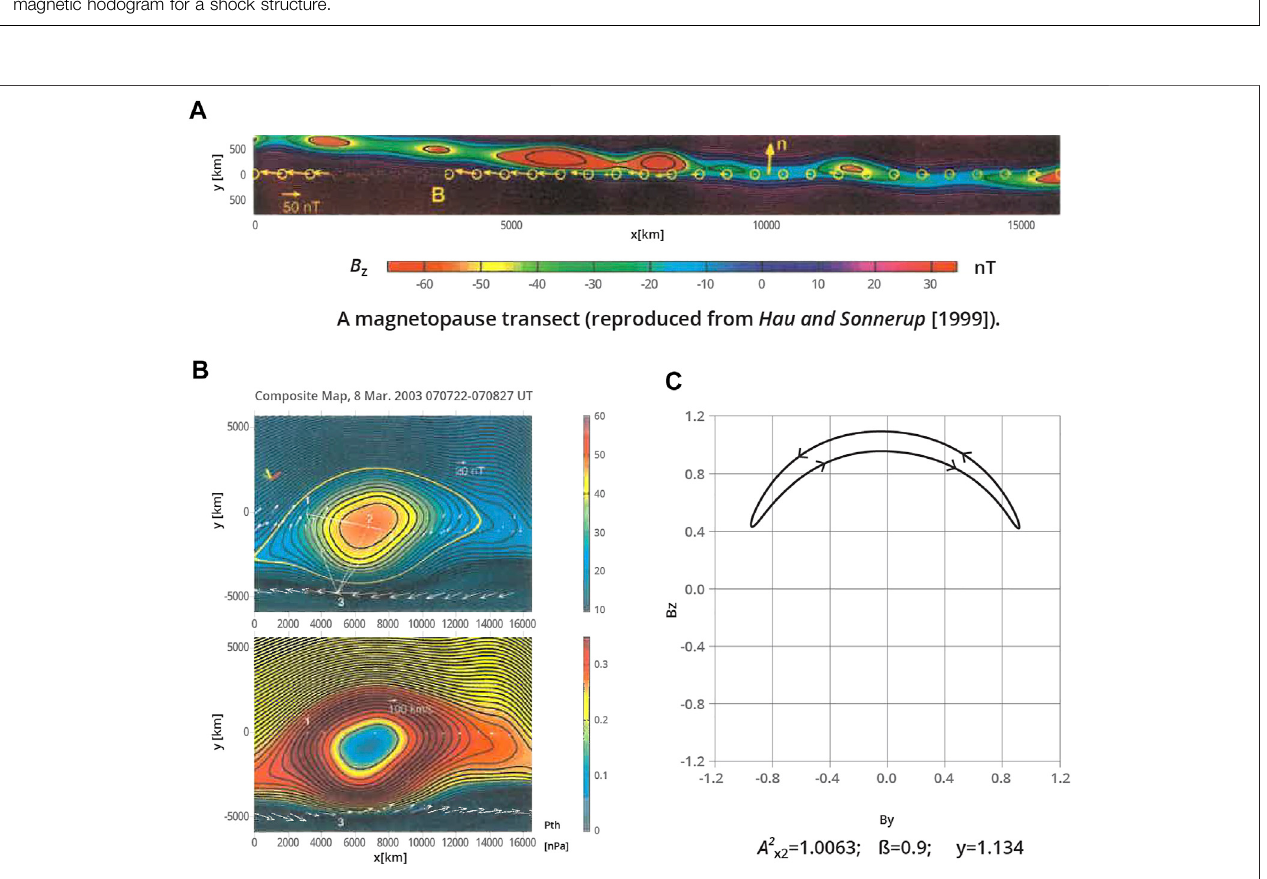
FIGURE 2 | Reconstruction: (A) Nearly tangential discontinuity behavior seen by AMPTE at the magnetopause; (B) Field and plasma pressure in a “ Flux transfer ” event. (C) Back and forth motion of the fi eld in arc-polarized waves.